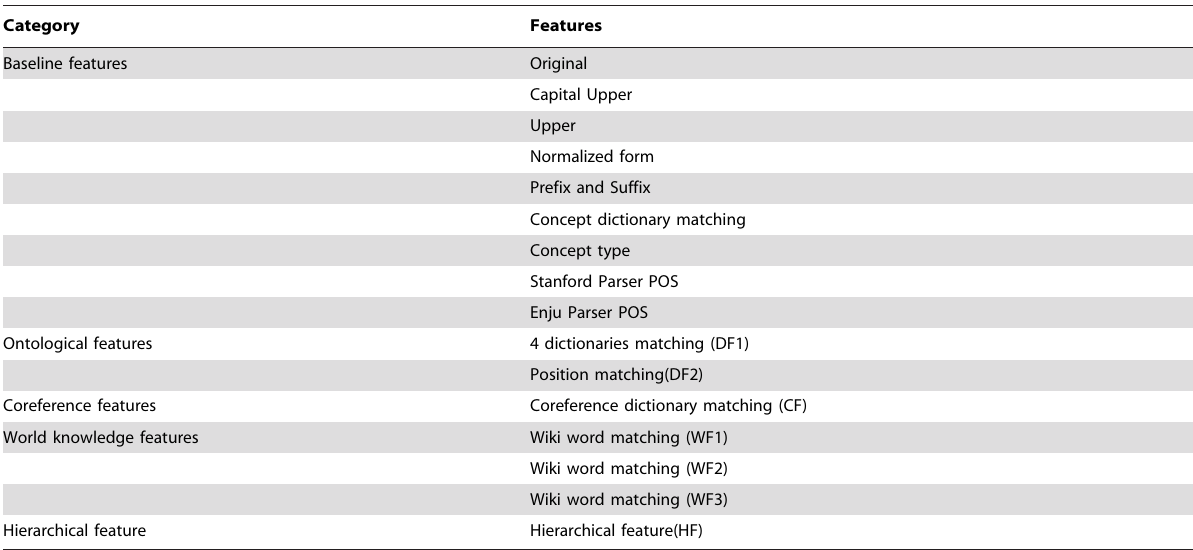
Table 3. List of features in this task.